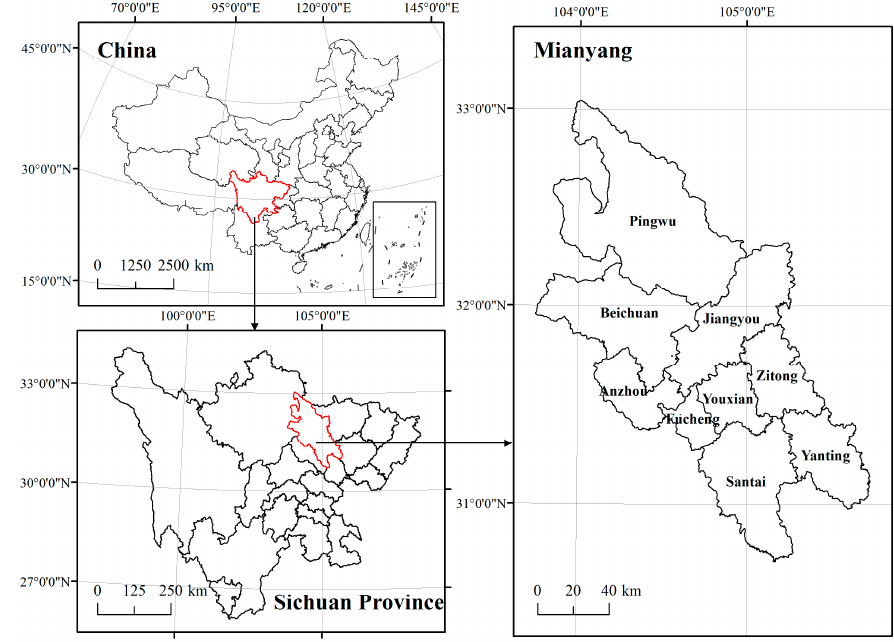
Figure 1. Location of the study area.